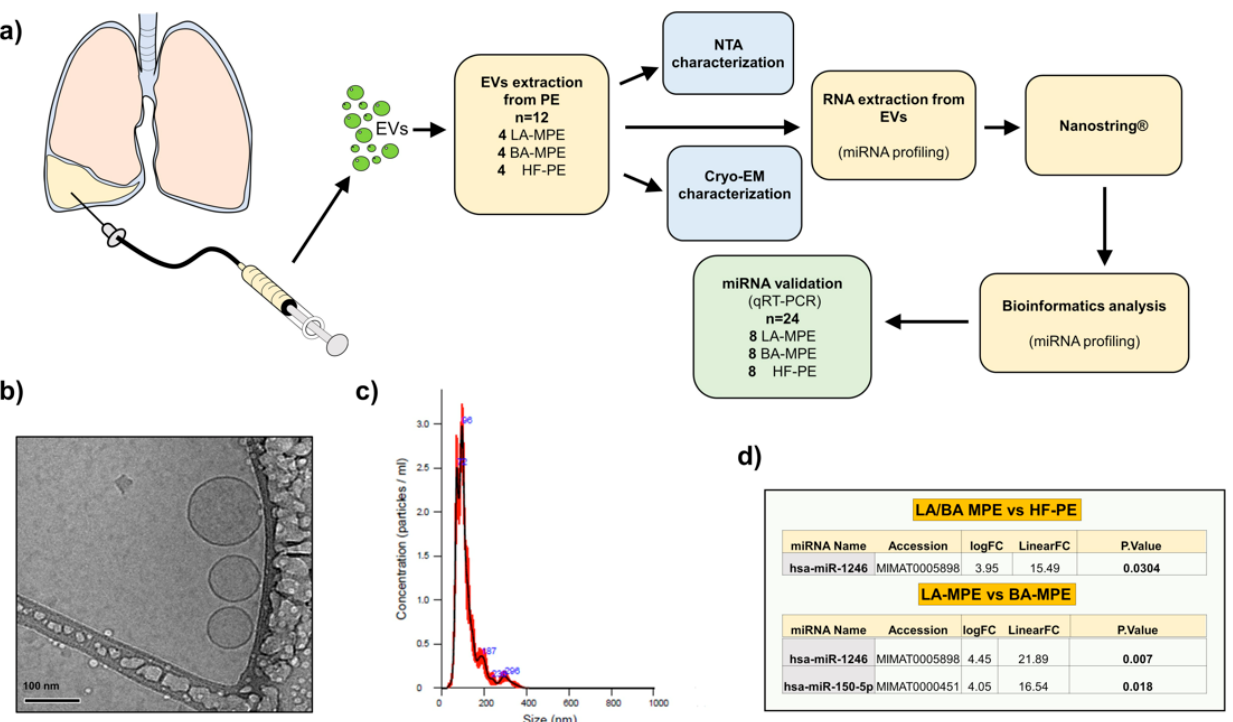
Figure 1. ( a ) Study schematic diagram with pictographic diagram of pleural fluid collection and EV extraction. ( b ) Cryo-EM images of extracellular vesicles isolated from pleural fluid and ( c ) nanoparticle tracking analysis (NTA). ( d ) Table of miRNA profiles: cancer (LA-MPE/BA-MPE) vs. HF-PE (top table) and breast vs. lung MPE (bottom table).